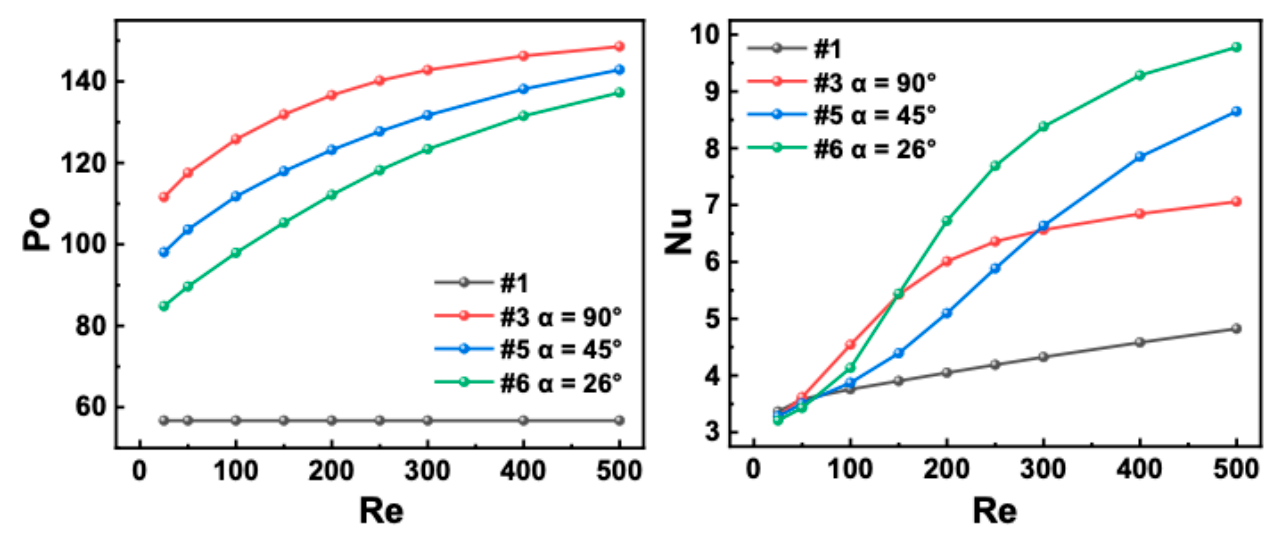
Figure 6. Po and Nu versus Re with different fin incident angles.